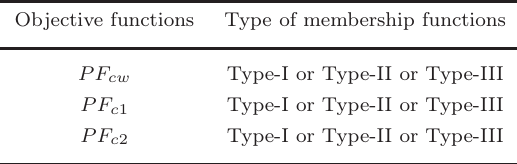
Table 4. Possible types of MF for objective